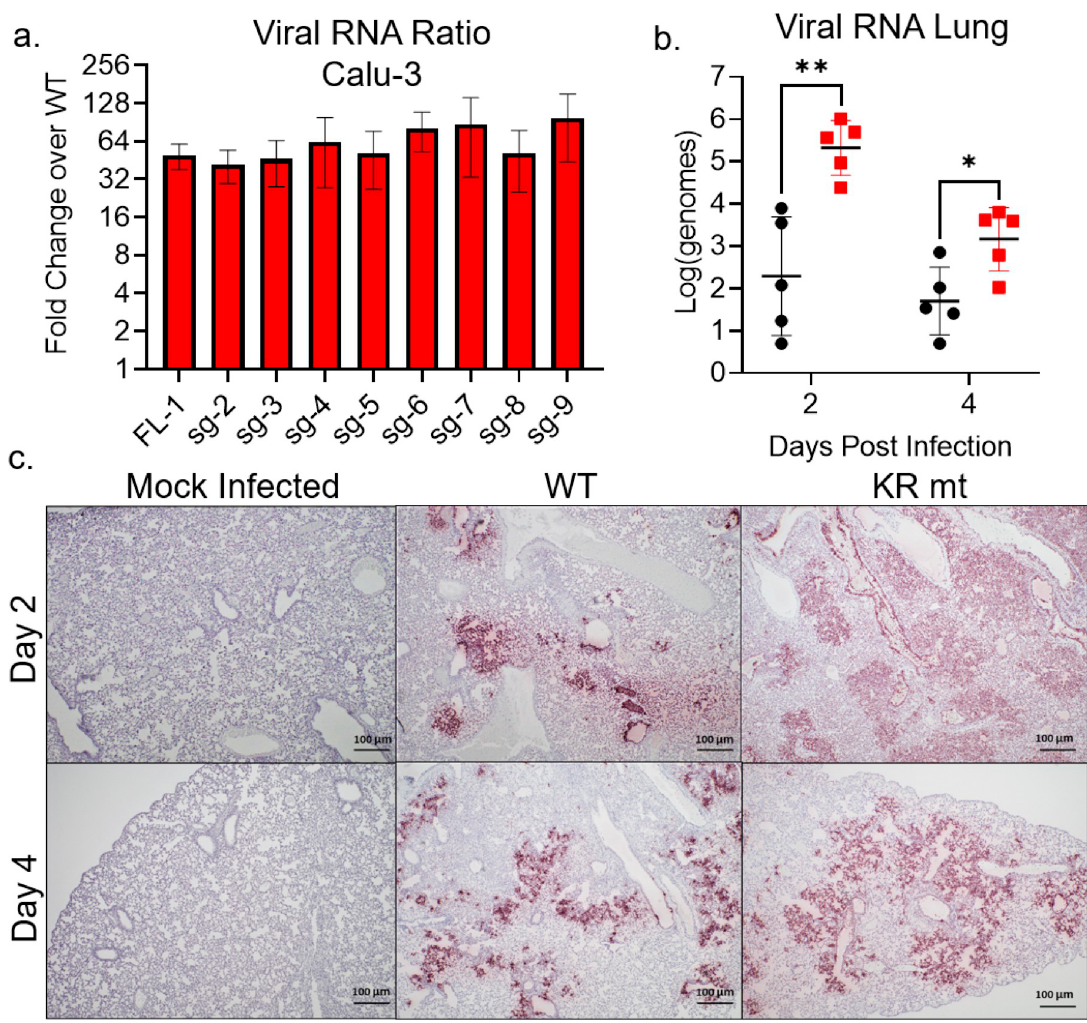
Fig 5. The KR mt increases levels of viral RNA and antigen. ( A ) Full-length and sub-genomic transcript levels 24 hours post infection from Calu-3 2b4 cells infected at an MOI of 0.01 with WT SARS-CoV-2 or the KR mt (n = 3). Transcript levels were normalized to 18S ribosomal RNA and graphed as the fold change in the KR mt relative to WT ( B-C ) Three- to four-week old male hamsters were inoculated with PBS (mock) or 10 4 PFU of WT or the KR mt. On days 2 and 4 post infection, lung tissue was harvested. The levels of full-length SARS-CoV-2 RNA in WT and KR mt infected animals (n = 5) (B). Representative SARS-CoV-2 antigen staining (anti- Nucleocapsid) of lung tissue from mock, WT, or KR mt infected animals (n = 5) ( C ). For in vitro transcripts, bars are mean titer ± s.d. For in vivo RNA, individual replicates are graphed with means ± s.d. indicated by lines. Significance was determined by student’s T-Test with p � 0.05 ( � ) and p � 0.01 ( ��